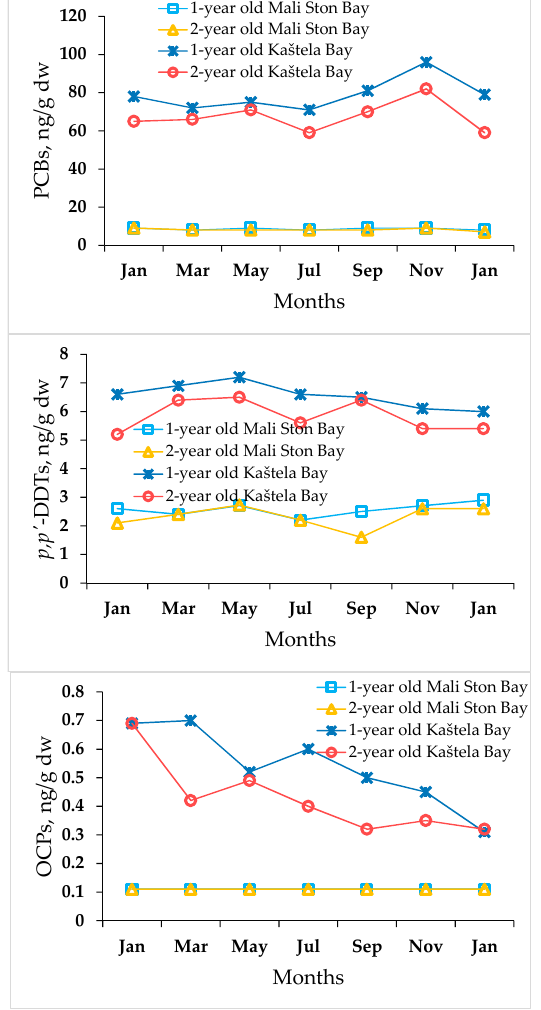
Figure 3. Polychlorinated biphenyls (PCBs), p,p’ -dichlorodiphenyltrichloroethane ( p,p ′ -DDTs) and organochlorine pesticides (OCPs) in 1- and 2-year-old mussels in Mali Ston Bay and the ones transplanted to Kaštela Bay, expressed as temporal variations.